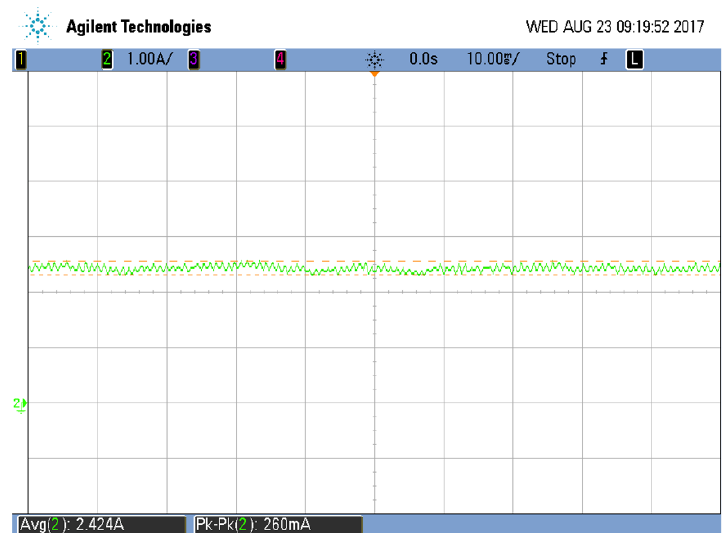
Figure 4. Oscillogram of the measured DC current of protection and control system’s DC auxiliary system in a small substation.